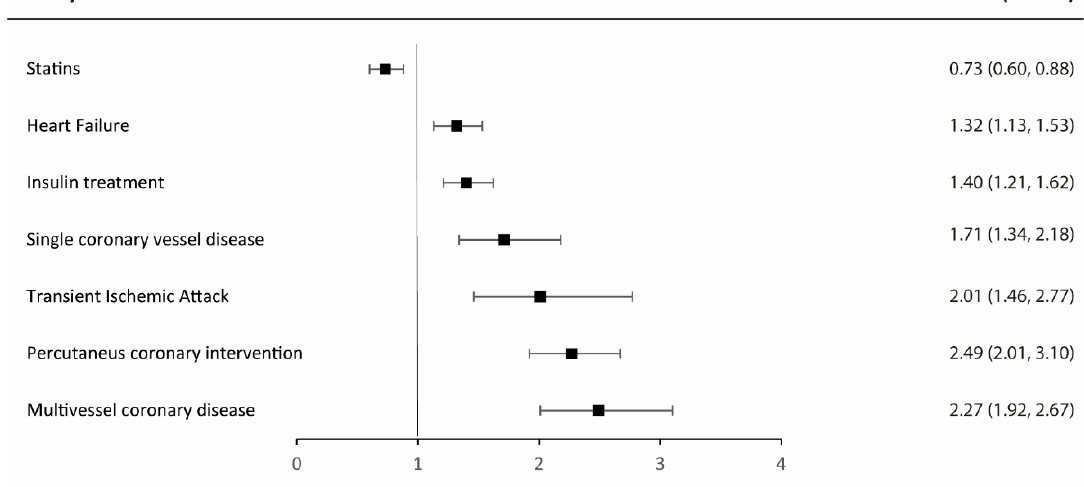
Figure 4. Forest plot of the 7 independent variables associated with the occurrence of MACE during the follow-up in the multivariable model.